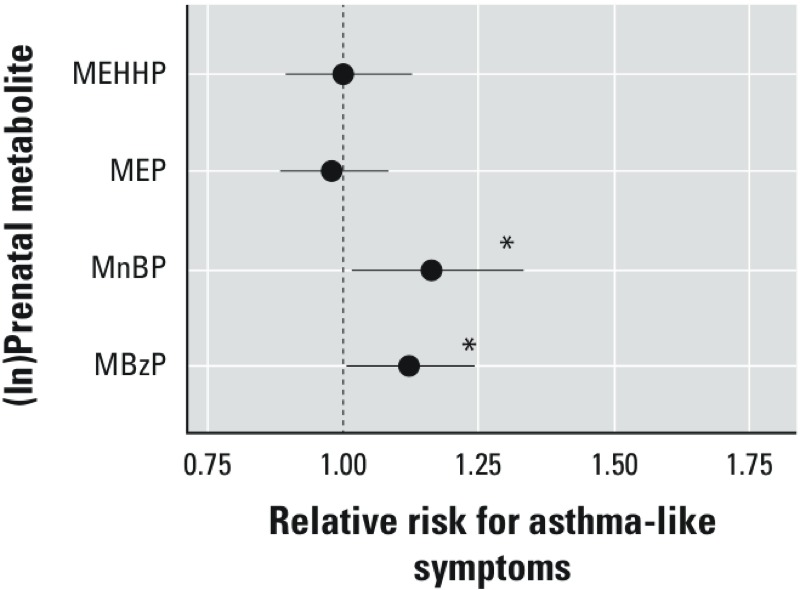
Association between maternal prenatal (ln)phthalate metabolite concentrations and presence (n = 154) compared with the absence (n = 146) of a history of asthma-like symptoms on repeat questionnaires administered between child ages 5 and 11 years. RRs were estimated using Poisson regression with robust standard error estimation using the generalized estimating equations controlling for maternal asthma, household tobacco smoke exposure, maternal prenatal BPA, maternal prenatal demoralization, and maternal prenatal specific gravity.
*p < 0.05.